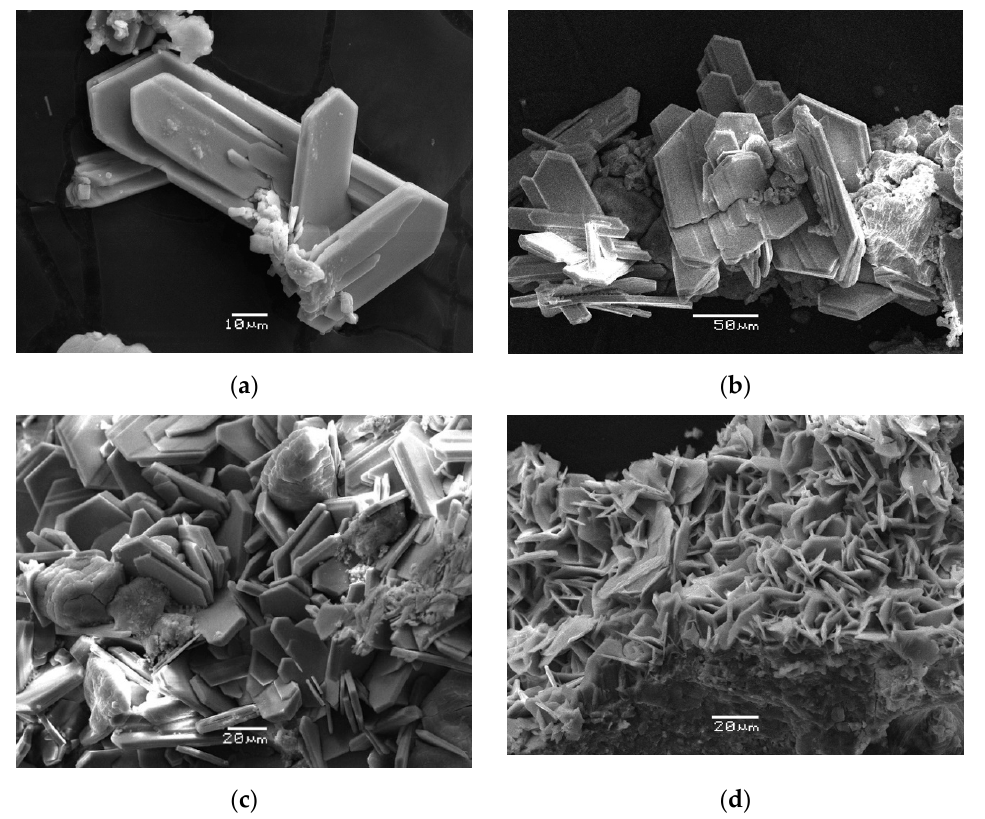
Figure 1. Morphology of dioskouriite from the Glavnaya Tenoritovaya fumarole ( a – c ) and from the Arsenatnaya fumarole ( d ): ( a , b )—crystal groups; ( c )—crystal crust with overgrowing crude equant crystals of carnallite; ( d )—crystal crust overgrowing basalt scoria. SEM (secondary electron, SE) images.